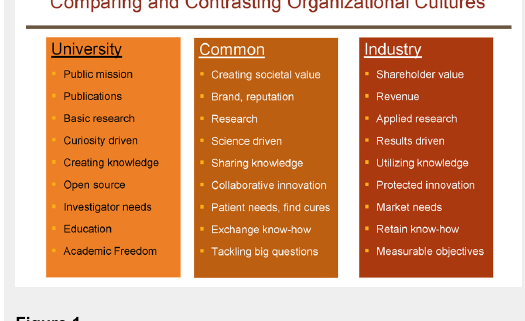
Comparison of the organisational cultures in universities and in the pharmaceutical industry. The traditional view on the collective processes and values that make up culture are indicated in the left and the right panels. Successful collaborations defy the polarised view, have a shared purpose and follow a paradigm based on common beliefs and assumptions (middle